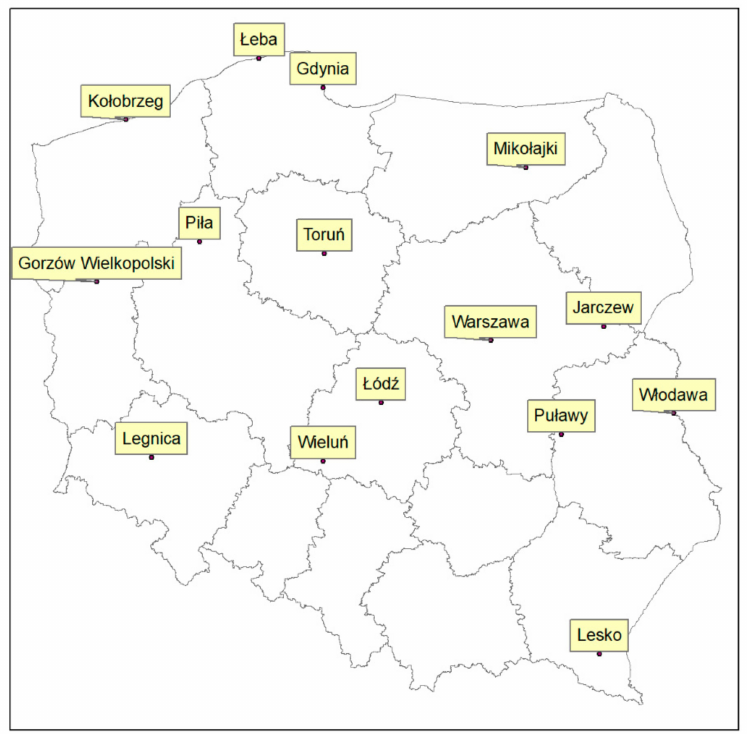
Figure 1. Locations of the